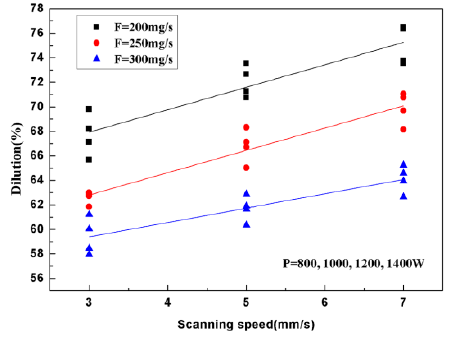
Figure 8. The effect of the main processing parameter on the dilution rate.